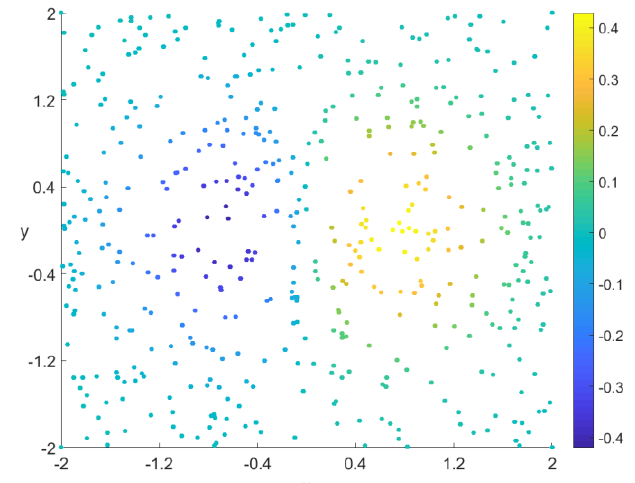
Figure 2. Location of data points over the whole